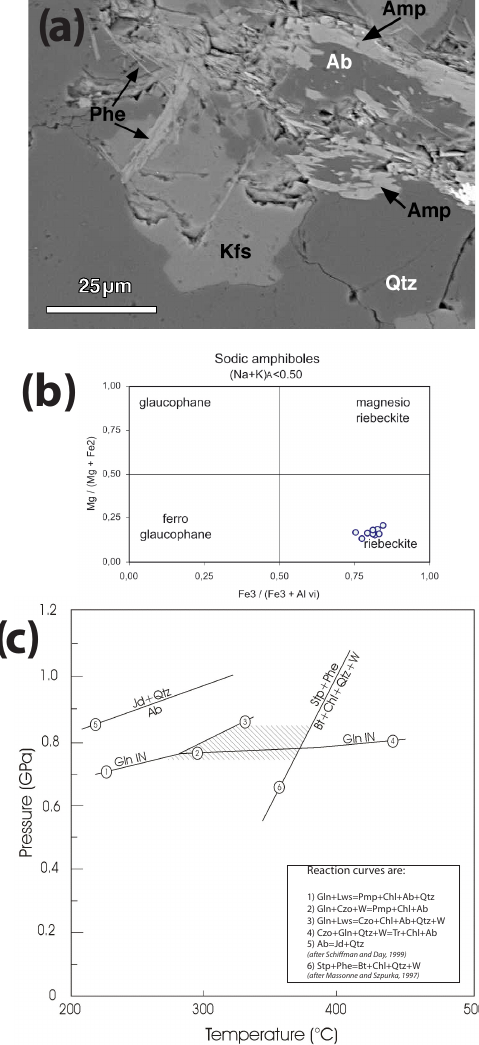
Figure 4. (a) Backscattered electron image of the metamorphic mineral assemblage in the host granitoids of the studied sample; Ab, albite; Amp, Na amphibole; Kfs, K-feldspar; Phe, phengite; and Qtz, quartz. (b) Composition of sodic amphiboles, using the clas- sification of Leake et al. (1997). (c) Estimated peak-metamorphic pressure and temperature conditions for the studied sample (cross- hatched area) constrained by the reactions indicated.